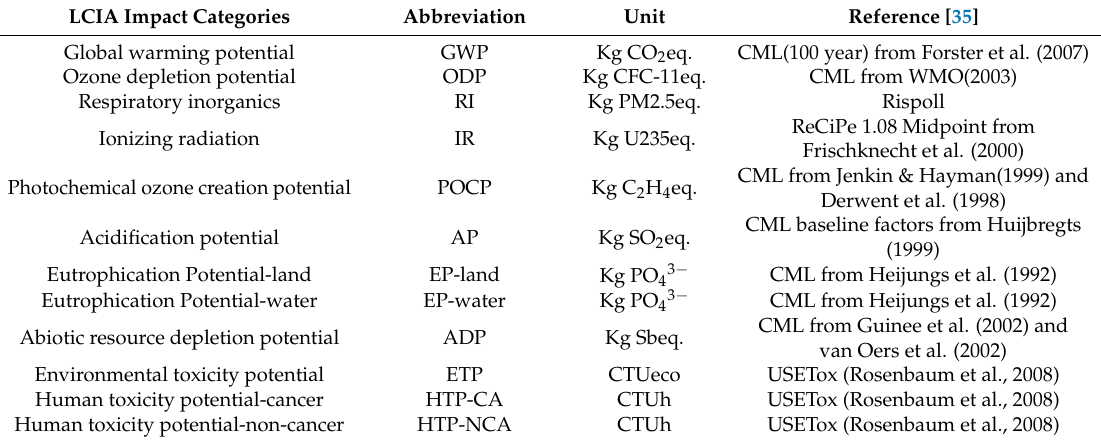
Table 3. The environmental categories on the basis of environmental